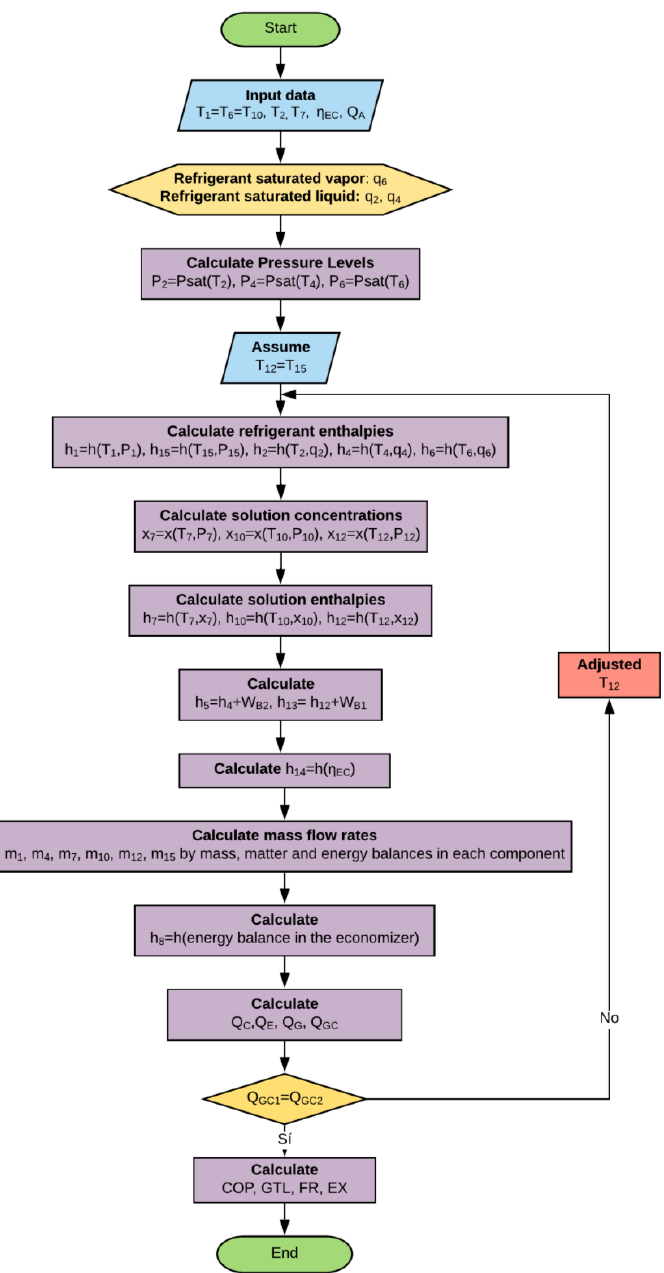
Figure 3. Algorithm flow chart for the modeling of the DEHT.